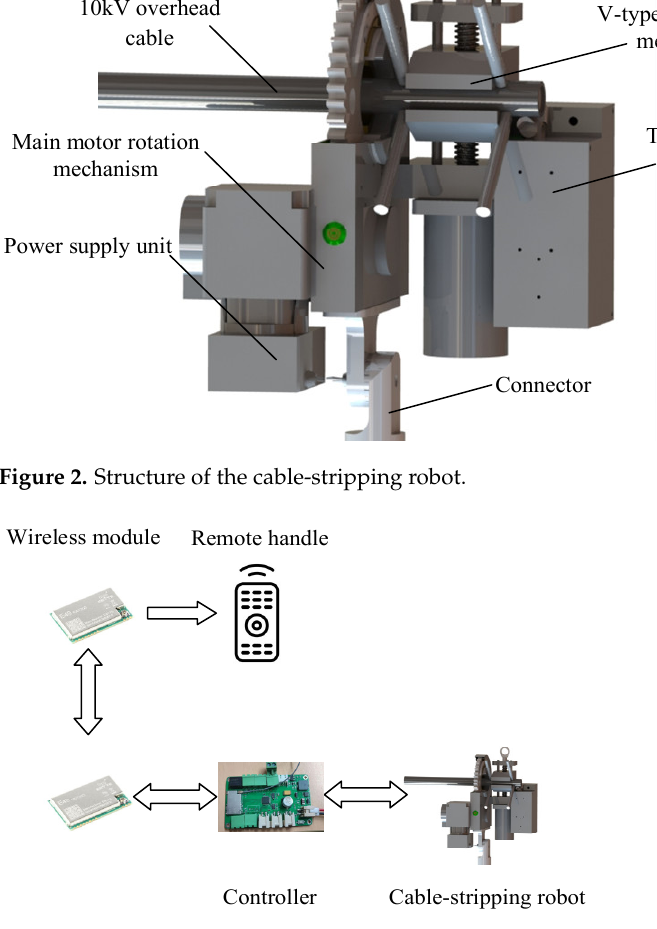
Figure 3. The entire cable-stripping robotic system.